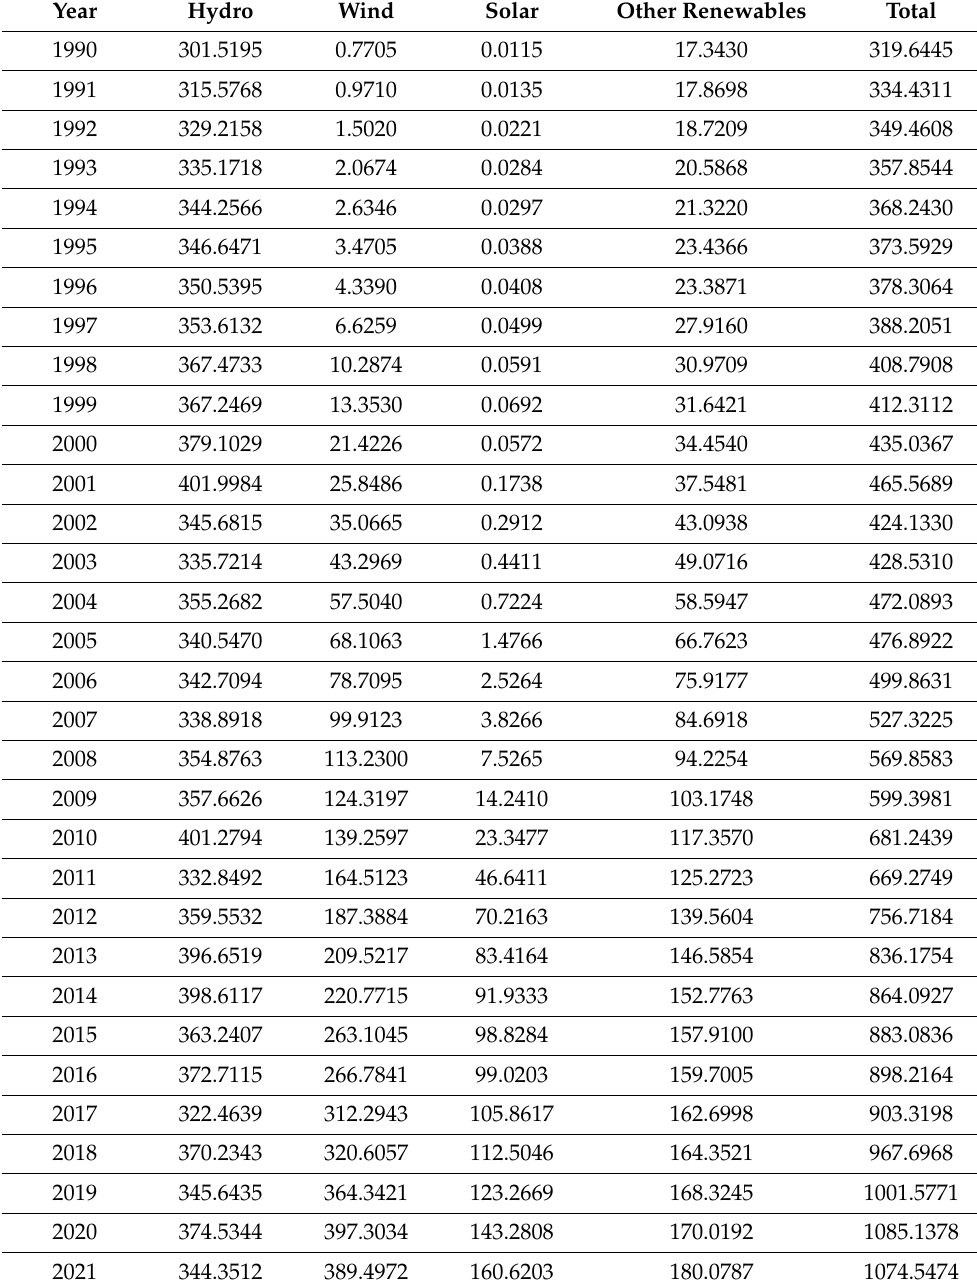
Table 1. Renewable electricity produced in EU27 in TWh